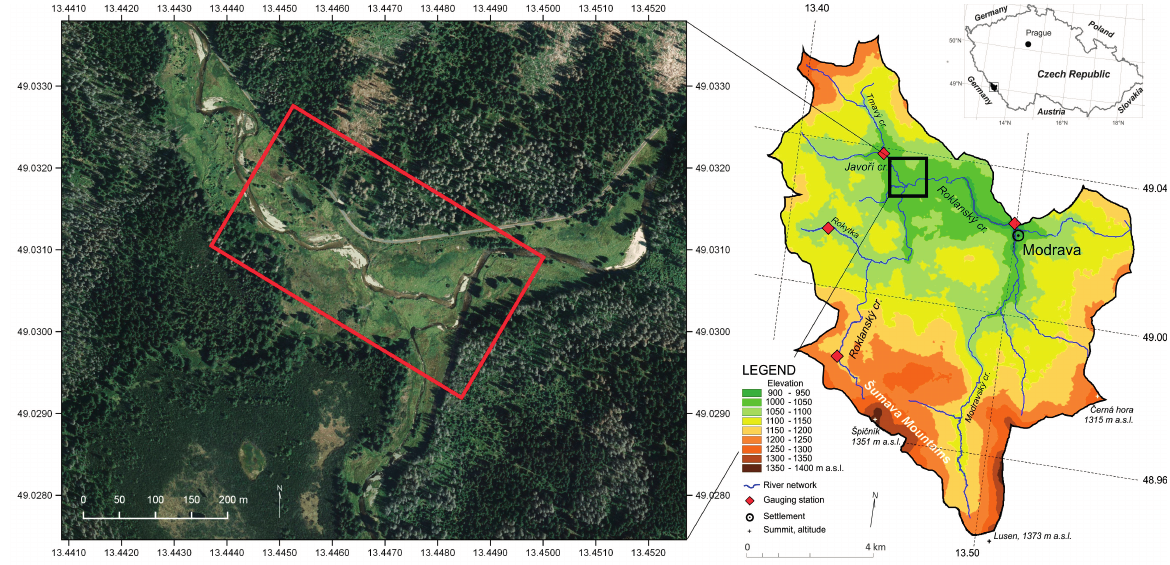
Figure 1. Study area: Confluence of Javo ř í and Roklanský brook with marked zone of UAS imaging ( left ) as a part of the upper Vydra Basin ( right